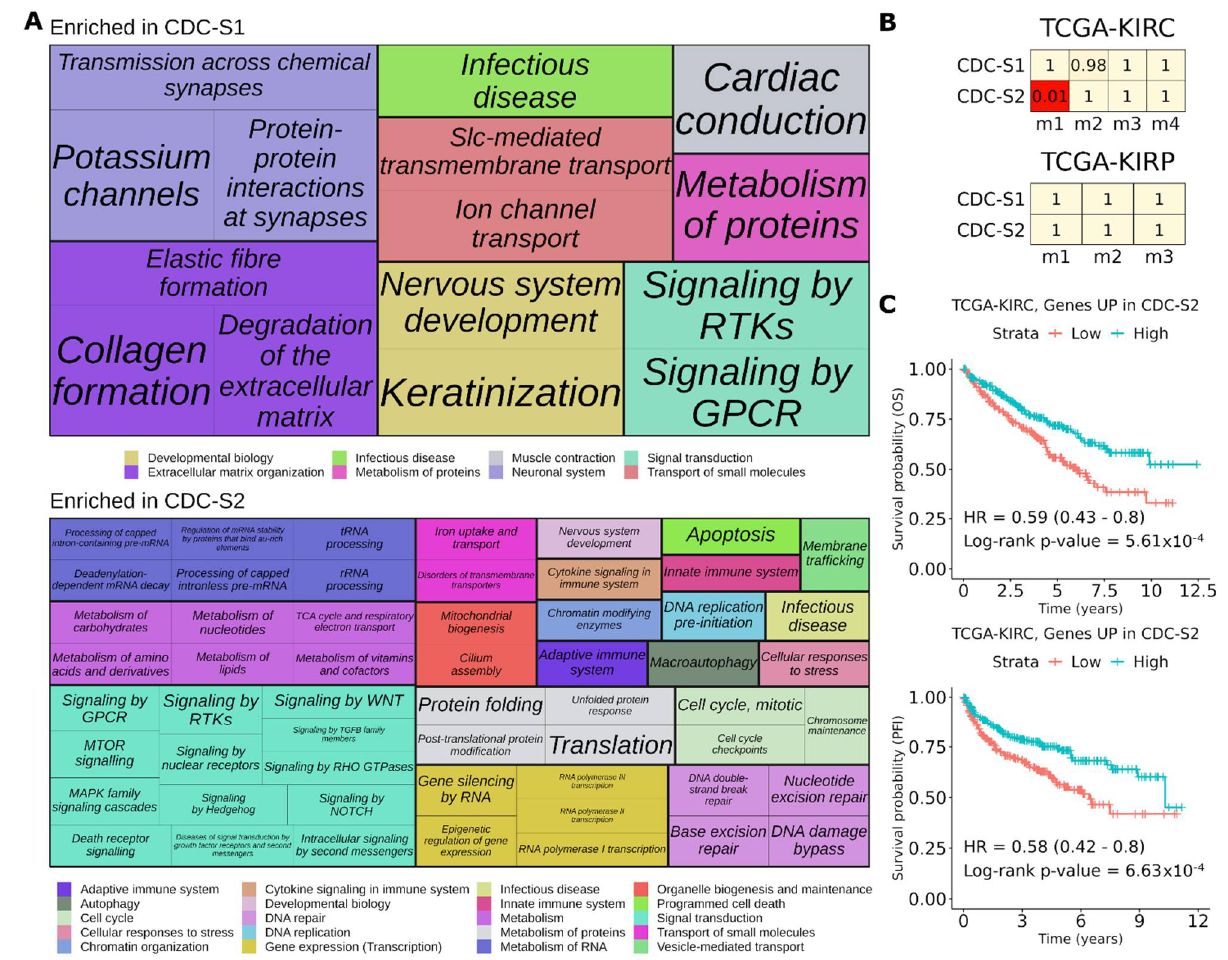
Figure 7. Functional analysis of CDC subtypes. ( A ) Treemap showing functional categories of Reactome gene sets significantly (FDR < 0.05) differentially enriched in CDC-S1 versus CDC-S2 subtypes. Gene sets were grouped according to the Reactome pathway hierarchy, and they are highlighted by different colors. ( B ) Bonferroni-adjusted p -values of the similarity between CDC and TCGA ccRCC (KIRC) or papillary (KIRP) subtypes. An adjusted p -value < 0.05 indicates significant similarity. ( C ) Kaplan–Meier curves referred to overall survival (OS, upper panel) and progression free-interval (PFI, lower panel) of TCGA ccRCC patients stratified according to the median expression of the top 150 genes upregulated in CDC-S2 subtype. HR: hazard ratio.